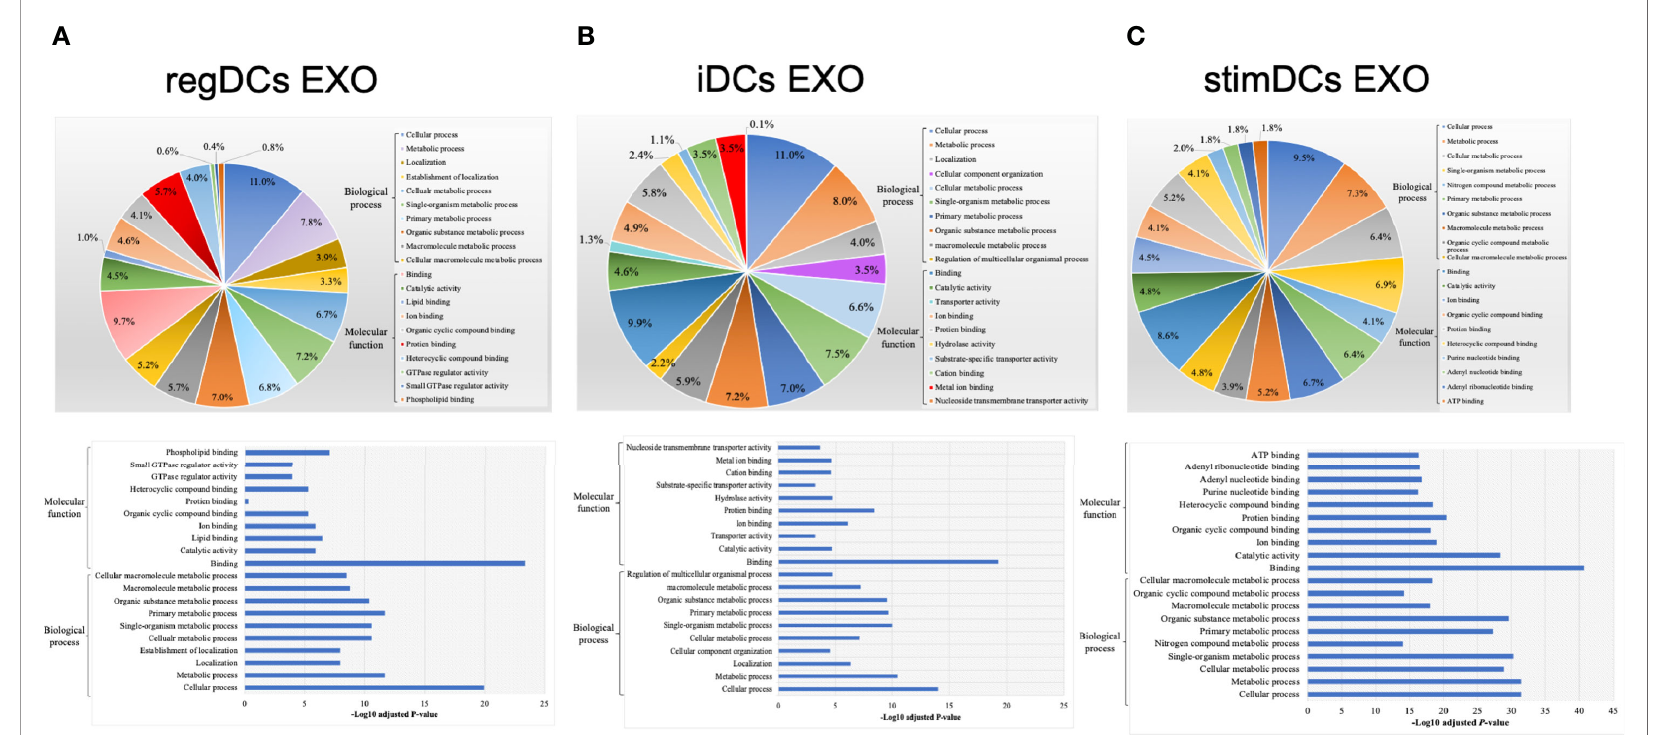
FIGURE 7 | Gene ontology (GO) enrichment analysis of the uniquely expressed proteins listed on their percentage (upper panel) and level of signi fi cance (lower panel) in (A) regDCs EXO, (B) iDCs EXO, and (C) stimDCs